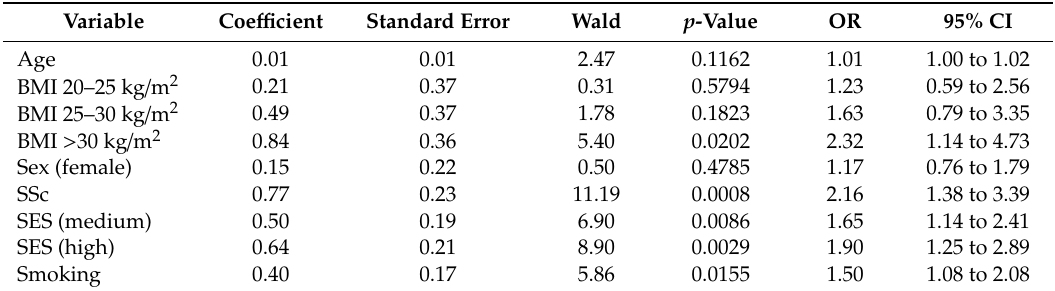
Table 3. Independent predictors for psoriasis (multivariate logistic